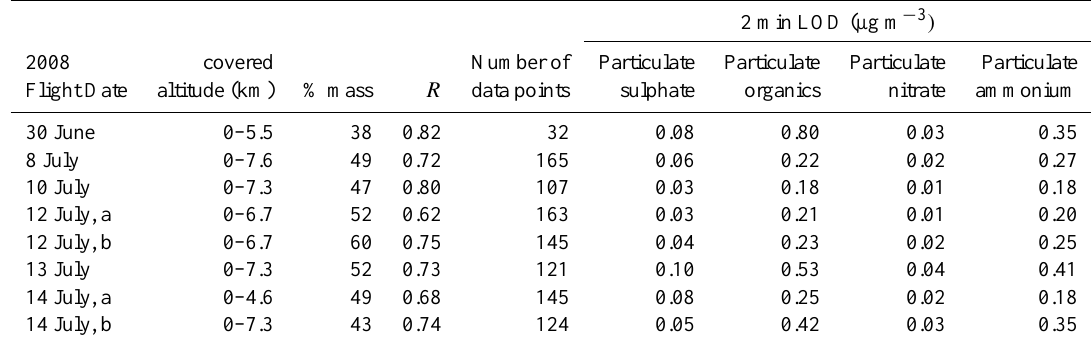
Table 2. Flight dates and altitude range covered by AMS measurements. Representation of total organic mass spectrum by the selection of organic m/z (% mass), Pearson correlation coefficient ( R ) of the linear regression, and average 2min 3 sigma limit of detection (LOD) for each